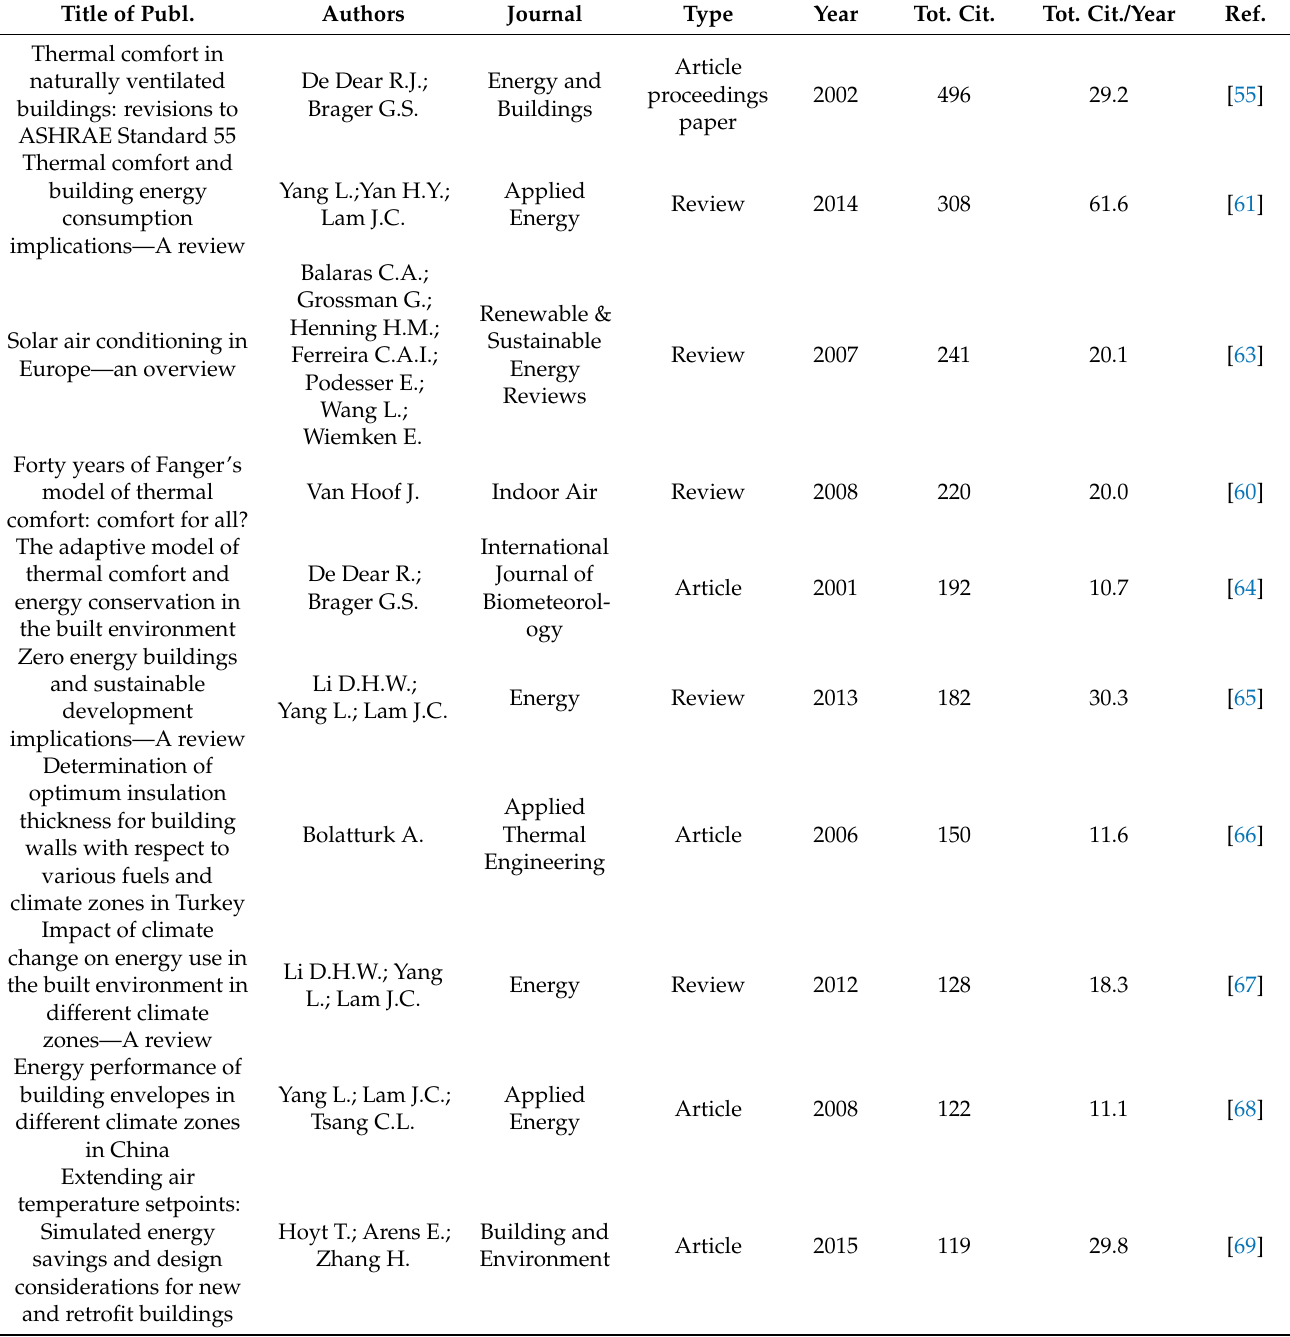
Table 1. The most-cited bibliography used in the analysed